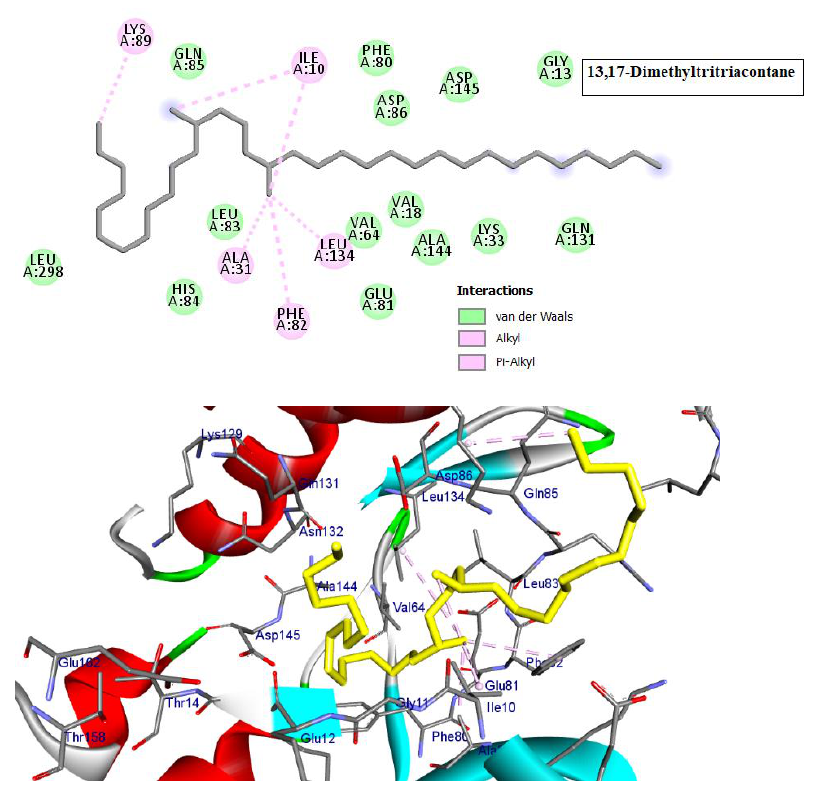
Figure 4. Two-dimensional and three-dimensional images of 13,17-dimethyltritriacontane docked into the ATP binding site CDK-2 enzyme.